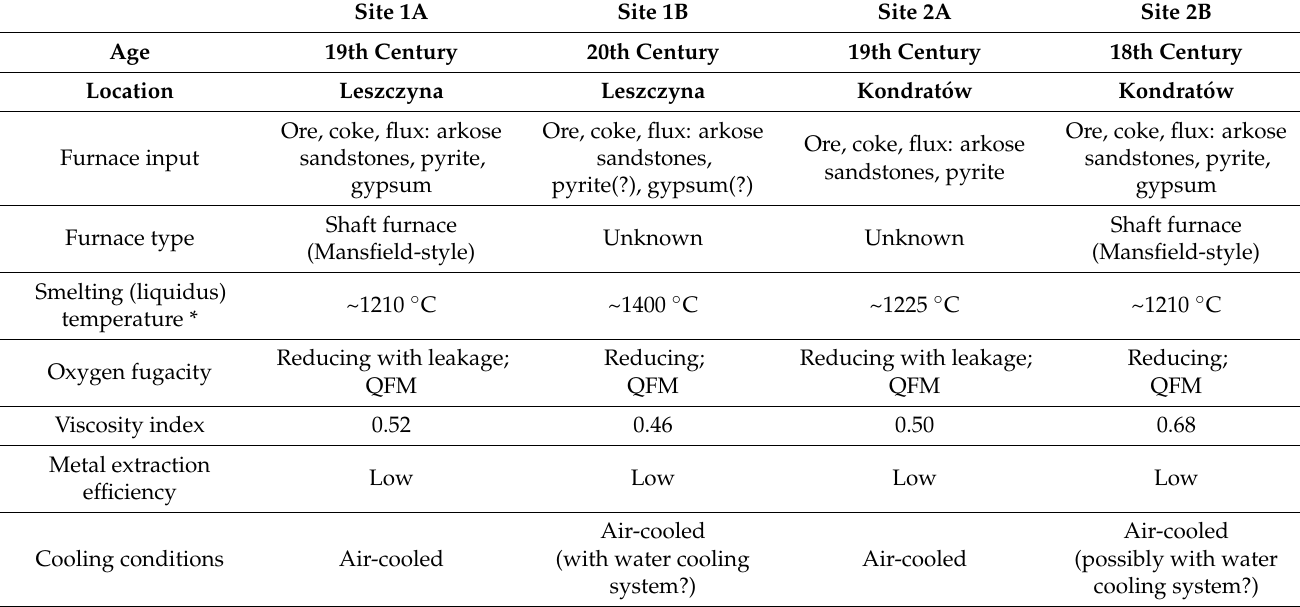
Table 8. Summary of the metal smelting conditions at all distinguished